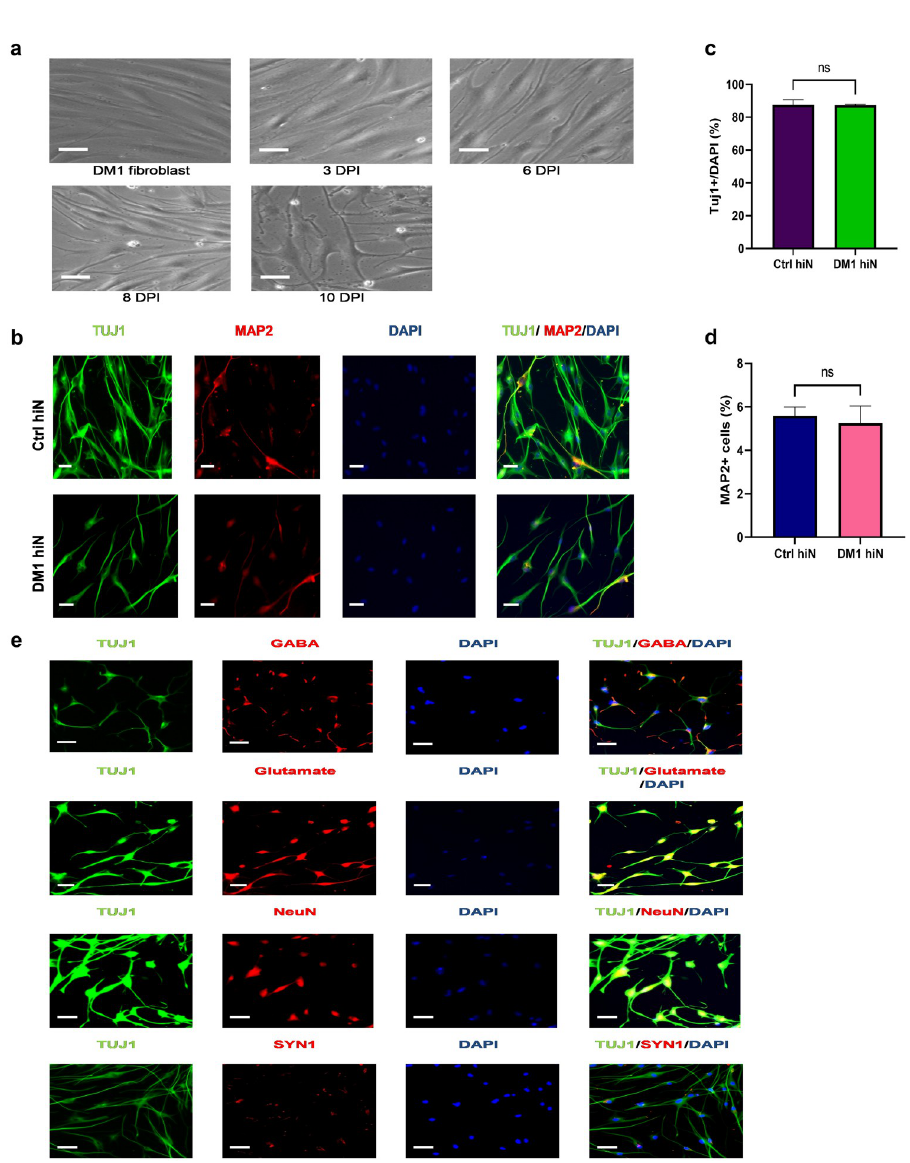
Fig 1. Direct reprogramming of DM1 patients’ skin fibroblasts into neuronal like cells. (a) Differentiation process of DM1 skin fibroblasts into neuronal like cells. The top left image shows DM1 skin fibroblasts before adding lentivirus co-expressing shRNA against PTBP and puromycin resistant gene. The top middle image shows lentivirus transduced cells successfully passing the selection process by adding 5 μ g/mL puromycin to the culture medium for 2 days. The top right image shows expansion of cell bodies at 6 DPI. The bottom left image shows cells with neuronal like morphology of expanded cell bodies and distinct neurites at 8 DPI. The bottom right image shows bipolar and multipolar neurons with extended neurites at 10 DPI. Scale bar, 50 μ m. (b) Co-immunostaining of control (top panel) and DM1 (bottom panel) hiNeurons with a neuron specific β -III tubulin antibody (TUJ1) (green) and MAP2 (red) at 10 DPI. DAPI was used to stain nuclei (blue). On the right: merged images of immunostaining with TUJ1, MAP2 and DAPI. Scale bar, 50 μ m. (c) Graph shows the percentage of positive TUJ1-stained cells (TUJ1 + ) at 10 DPI, quantified by dividing the number of TUJ1 + cells by the total number of nuclei stained by DAPI. Data are shown as mean ± SEM; n = 3 for each group, a total of 90 images were analyzed per group (11,510 nuclei were analyzed per ctrl group and 14,668 nuclei per DM1 group). ns, not significant compared to control group by unpaired t-test. (d) Graph displays the percentage of MAP2 positive cells at 10 DPI, quantified by dividing the number of MAP2 + cells by the total number of TUJ1 + cells. Data are shown as mean ± SEM; n = 3 for each group, a total of 90 images were analyzed per group (9,941 TUJ1 + cells were analyzed per ctrl group and 16,286 TUJ1 + cells per DM1 group). ns, not significant compared to control group by unpaired t-test. (e) Additional staining for neural markers. Fluorescent images display positive co- staining of DM1 hiNeurons with TUJ1 (green) and anti GABA or glutamate or NeuN (red) antibodies at 15 DPI. The bottom panel shows lack of synapse formation at 10 DPI in DM1 hiNeurons co-stained with TUJ1 (green) and